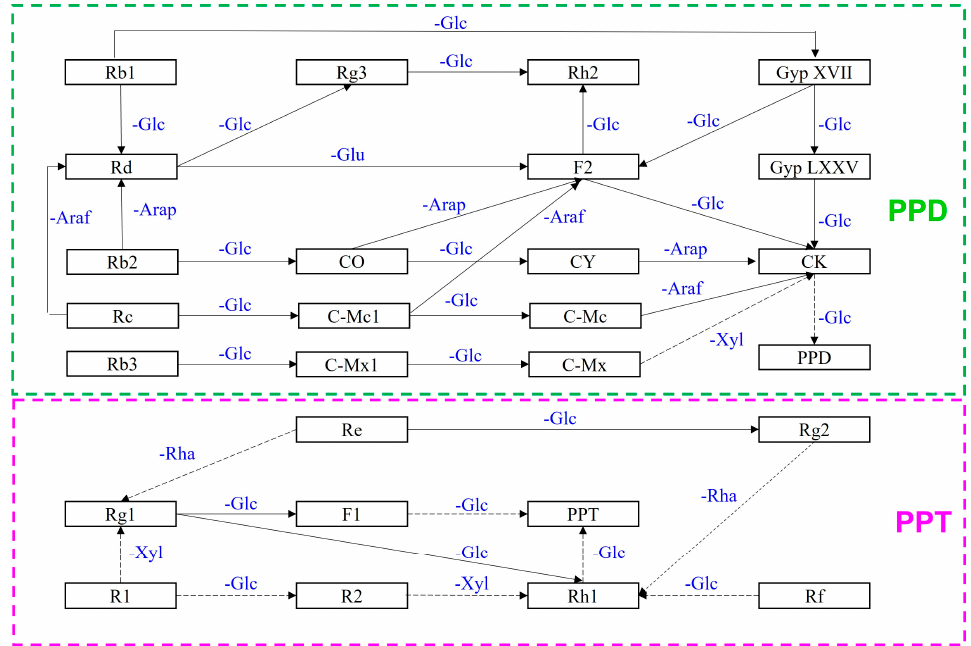
Figure 2. Overview of ginsenoside bioconversion. The PPD and PPT pathways are indicated in the green and pink boxes, respectively. The changed sugar moieties are showed in blue. The abbreviations of sugar moieties are as follows: Glc: D-glucose, Arap: L-arabinopyranoside, Araf: L-arabinofuranoside; Xyl: D-xylose; Rha: L-rhamnose. The marked ‘’-‘’ before sugar moieties indicted the hydrolysis. The lid arrows represent confirmed conversion pathways. Interrupted arrows indicate predicted biotransformation